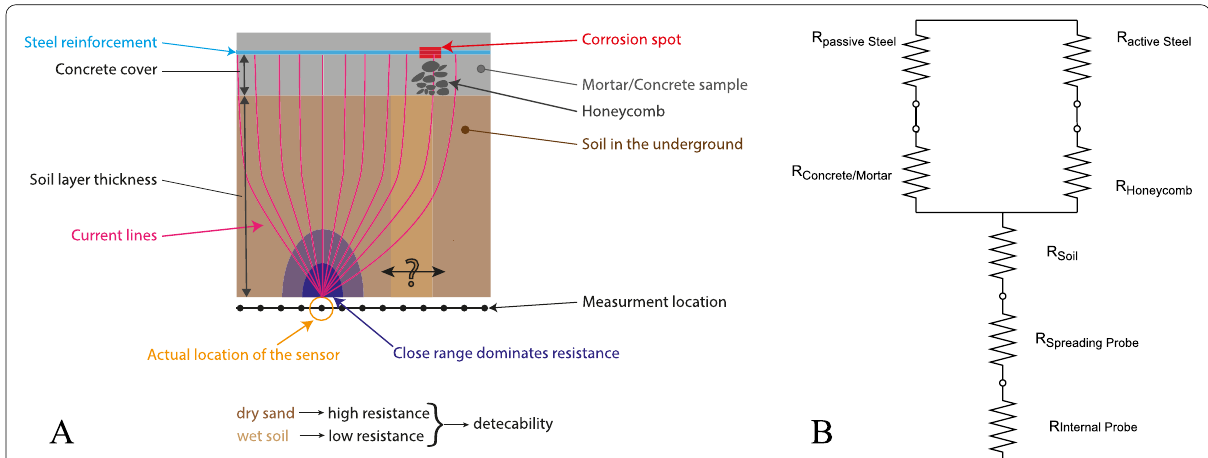
Fig. 17 Possible influencing factors for detecting corrosion of RC members in soil: A Sketch of the underground with the reinforced sample and B electrical circuit of the